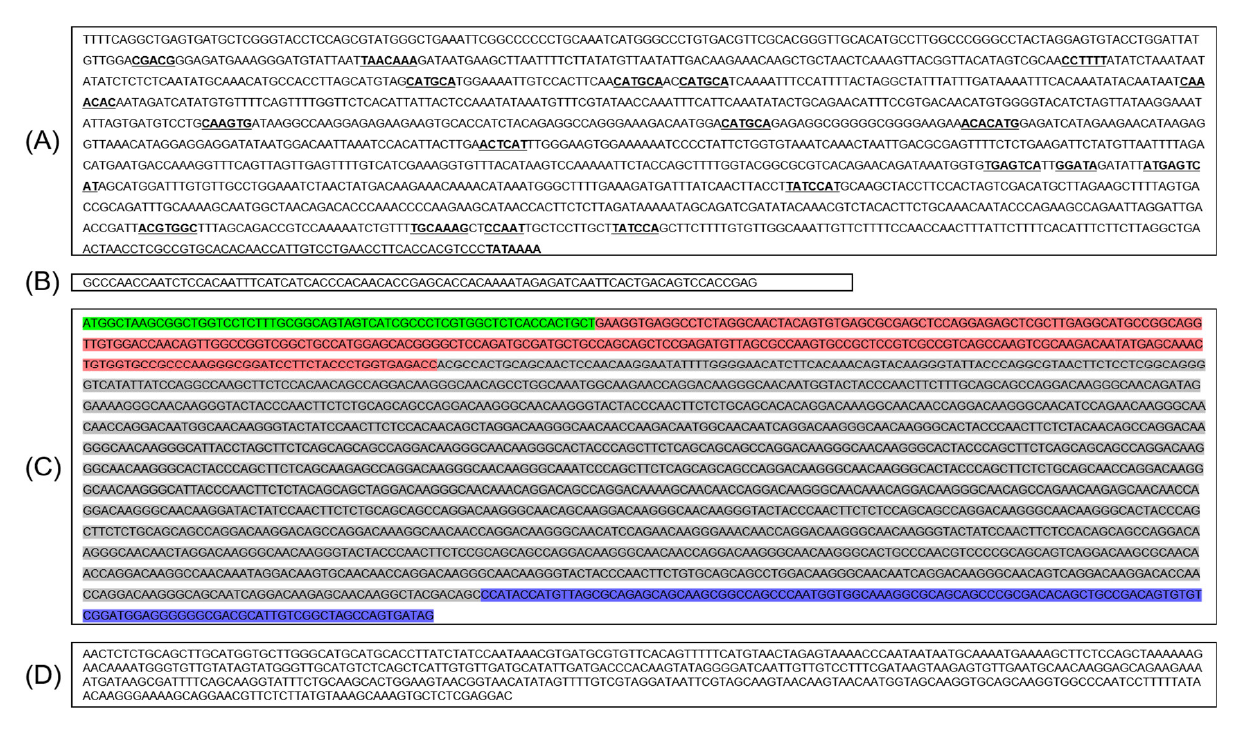
Figure 4. Complete Keumgang TaHMW1D gene sequence, including the ( A ) promoter, ( B ) 5′ UTR, ( C ) CDS, and ( D ) 3′ UTR. Bold and underlined, transcription factor binding sites; green, signal peptide region; pink, N-terminal region; gray, repetitive region; blue, C-terminal region.